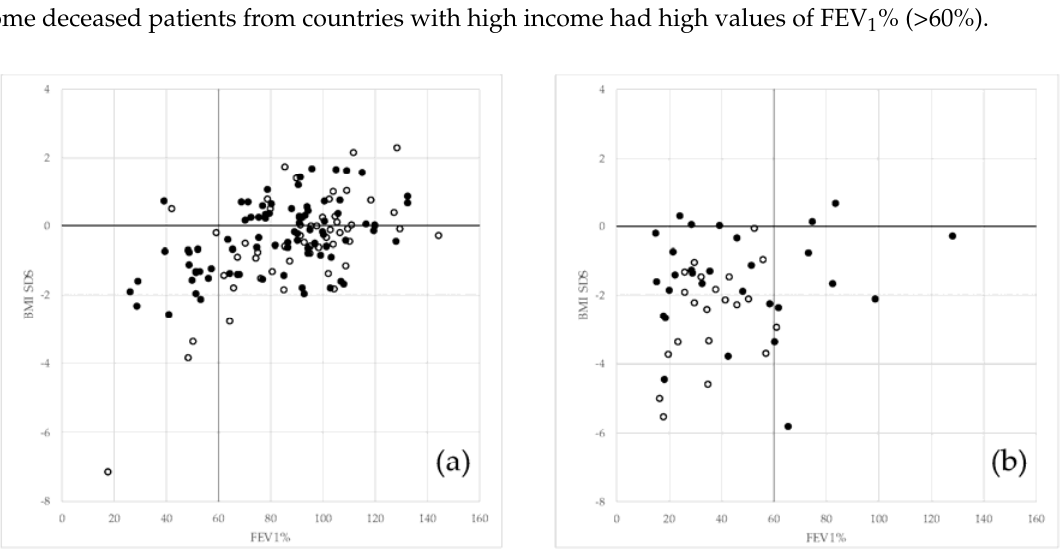
Figure 2. ( a ): alive patients from low/middle income countries (empty bullet) and from high income countries (circle bullet) by BMI and lung function. ( b ): deceased patients from low/middle income countries (empty bullet) and from high income countries (circle bullet) by BMI and lung function.